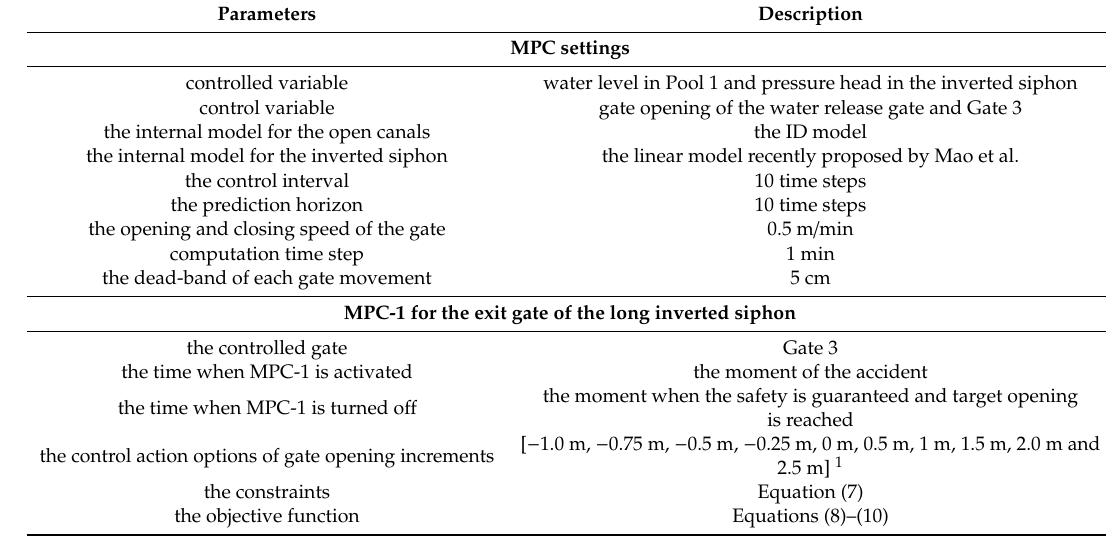
Table 2. Details of the control